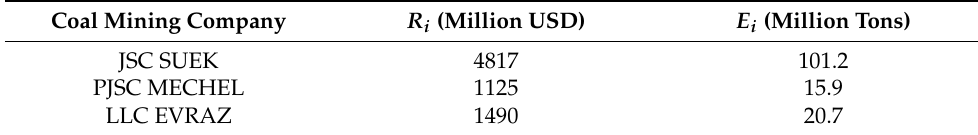
Table 1. Enterprise data.